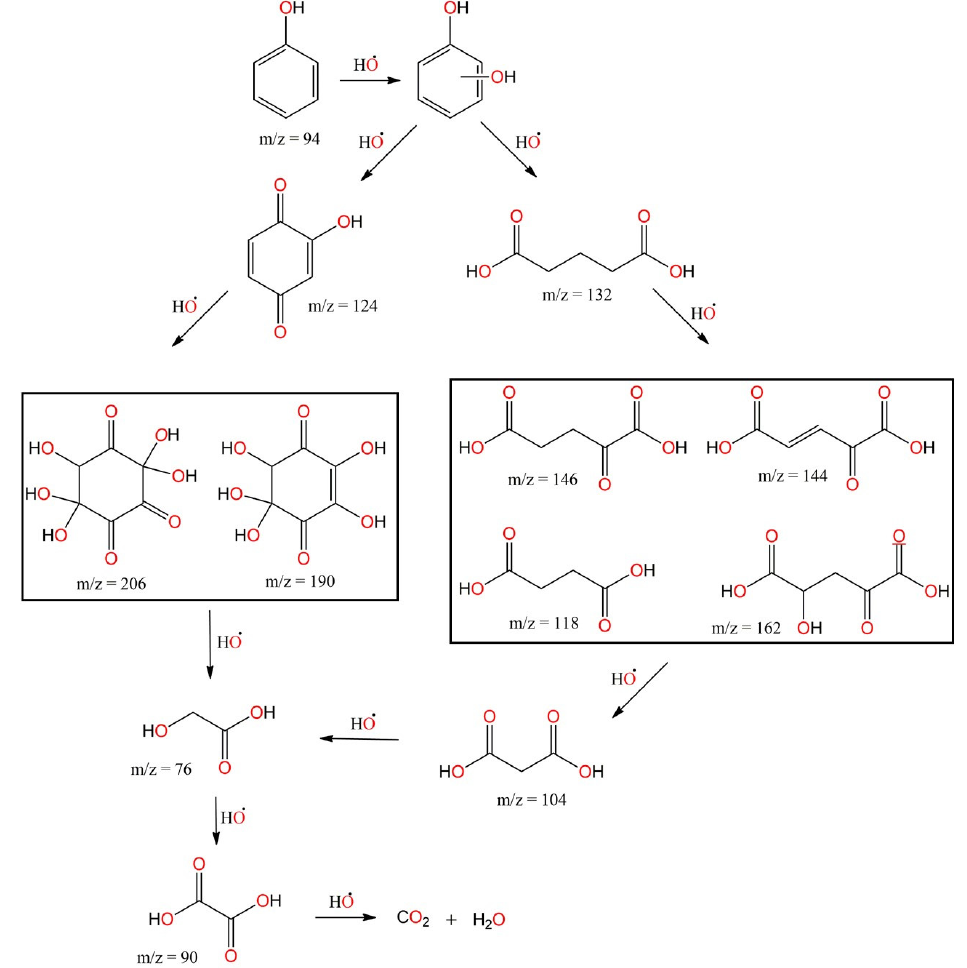
Figure 10. Proposed phenol degradation pathway of the Au/TiO 2 /NTO catalyst detected with GC-MS.